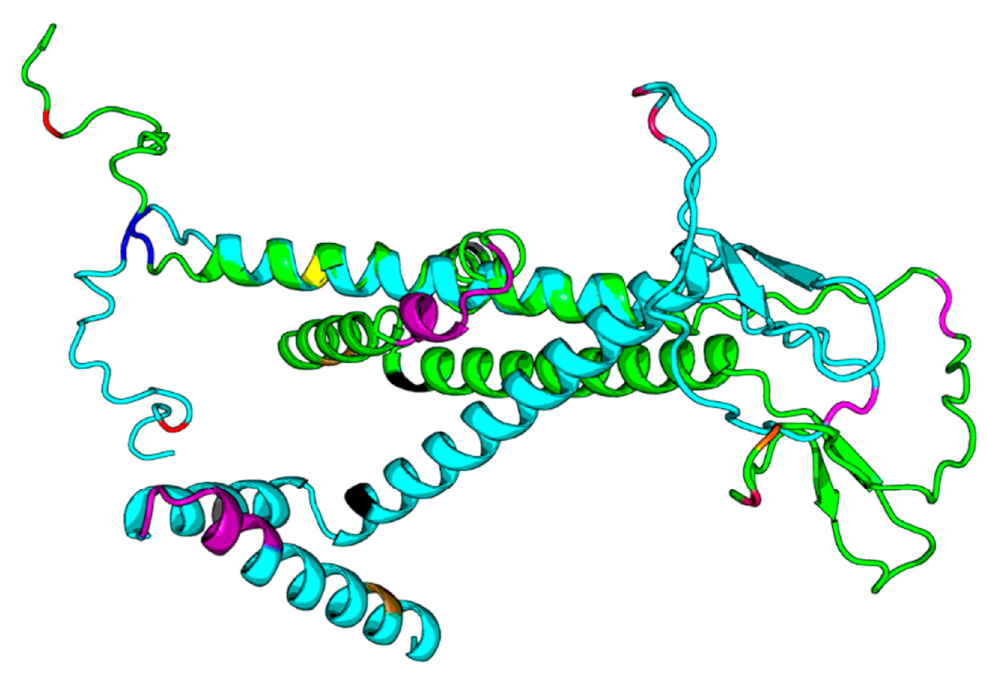
Figure 5. DF292. DF293.png. Legend: The green structure in the png file is DF292 (HBV consensus), and the cyan one is DF293 (HBV_800 isolate), and we highlight the sequence differences in the structure model with different colors. The two models both have N-terminus helix regions and C-terminus helix regions; however, the orientations between those two helix regions of the two models are quite different.